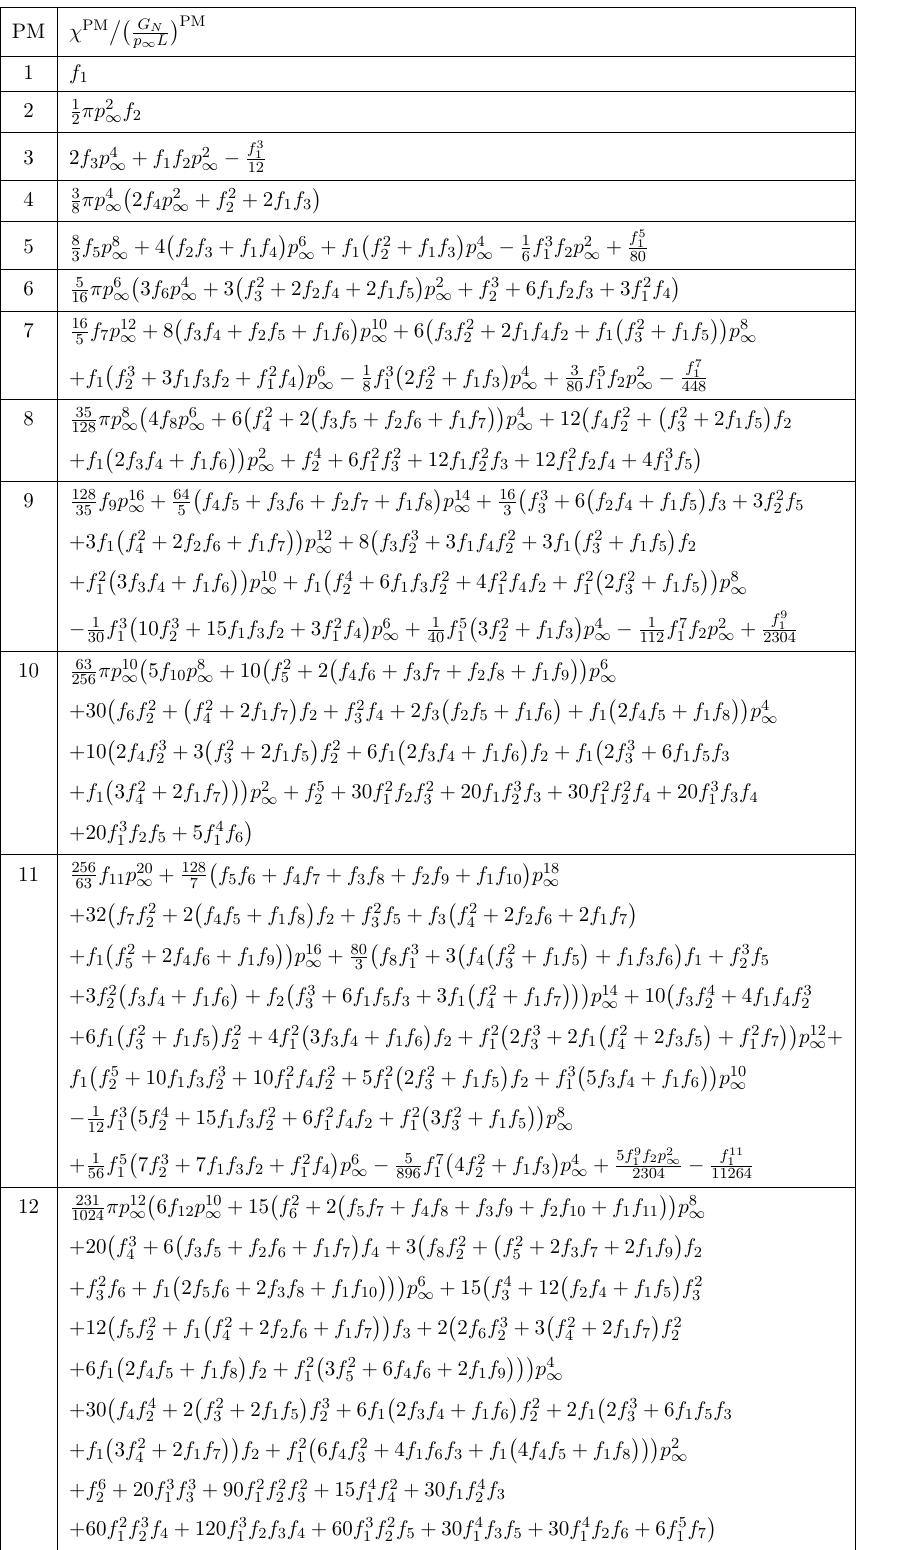
Table 1 . PM corrections to 12th order in G N